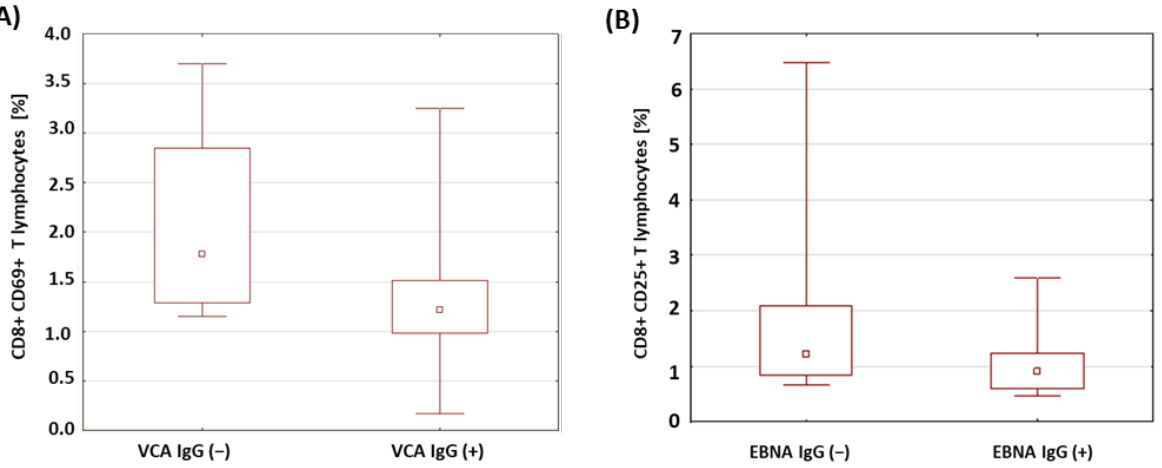
Figure 5. Comparison of the percentages of selected subpopulations of lymphocytes expressing the CD69 antigen in a group of patients with type 1 diabetes in relation to the presence of anti-VCA and